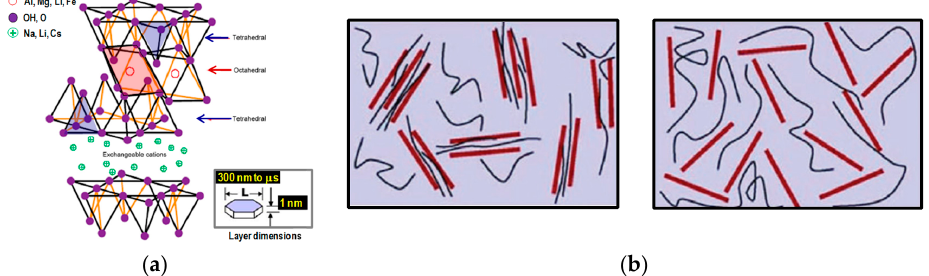
Figure 2. ( a ) Structure of layered alumino-silicate and ( b ) intercalated (left) and exfoliated (right) morphology of layered alumino-silicate into polymer and biopolymer matrices [32], Reproduced with permission from Bayer G, Plast Addit Compound; published by Elsevier, 2002 .